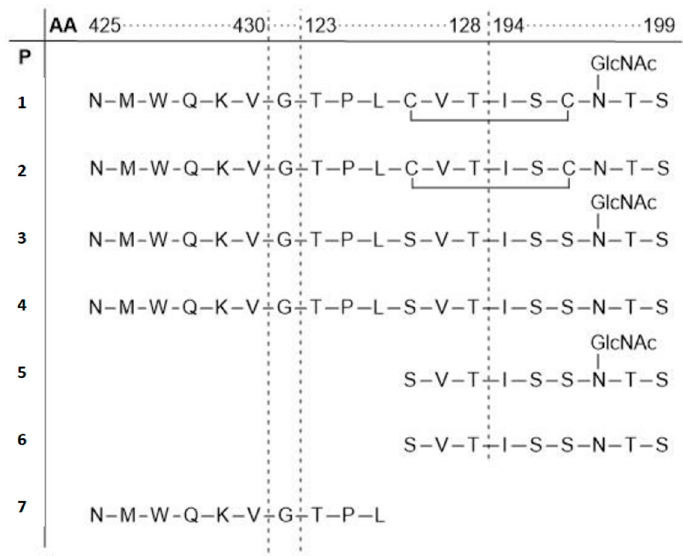
Figure 11. Overview of synthetic gp120 C -terminal amidated peptides and glycopeptides prepared by the Meyer group. The amino acid numbers are assigned to their position in the gp120 of HIV-1. Peptides 1 – 4 bound to CD4 in the micromolar range. Preferred binding to glycosylated